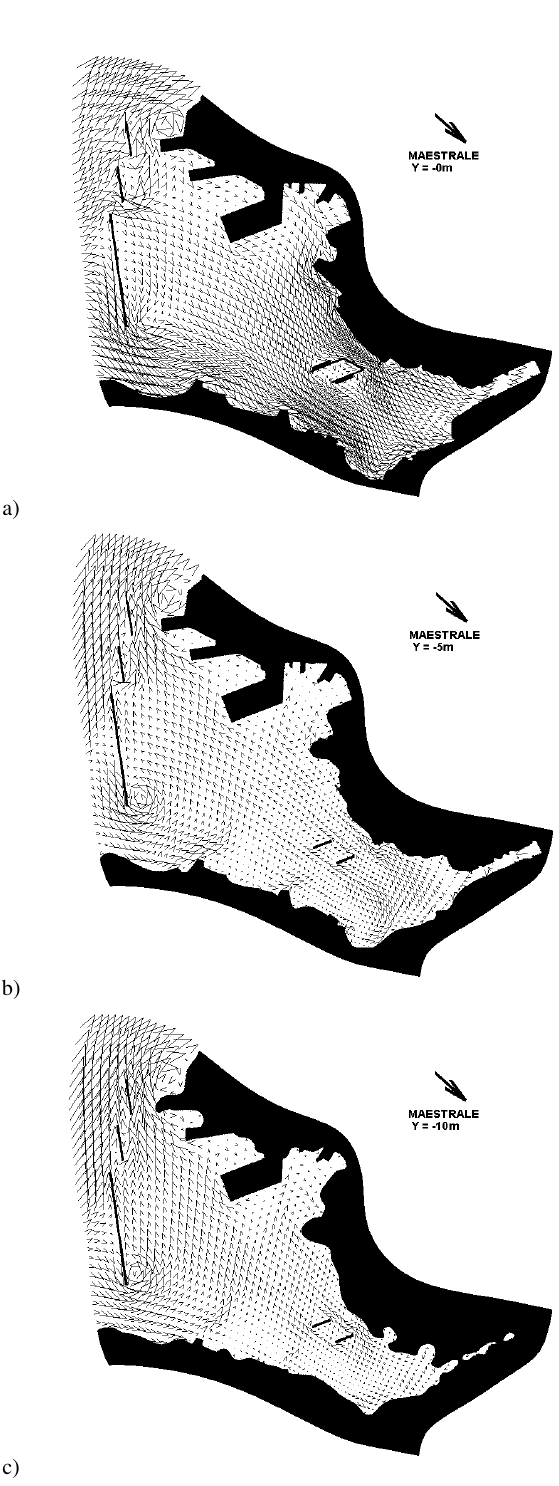
Fig. 15. Horizontal velocity vector field for Maestrale wind simula- tion averaged over a period of three hours; for clarity purposes, only one vector is shown every 15 points in x and z . (a) Sea surface; (b) 5m below the sea surface; (c) 10m below the free surface.